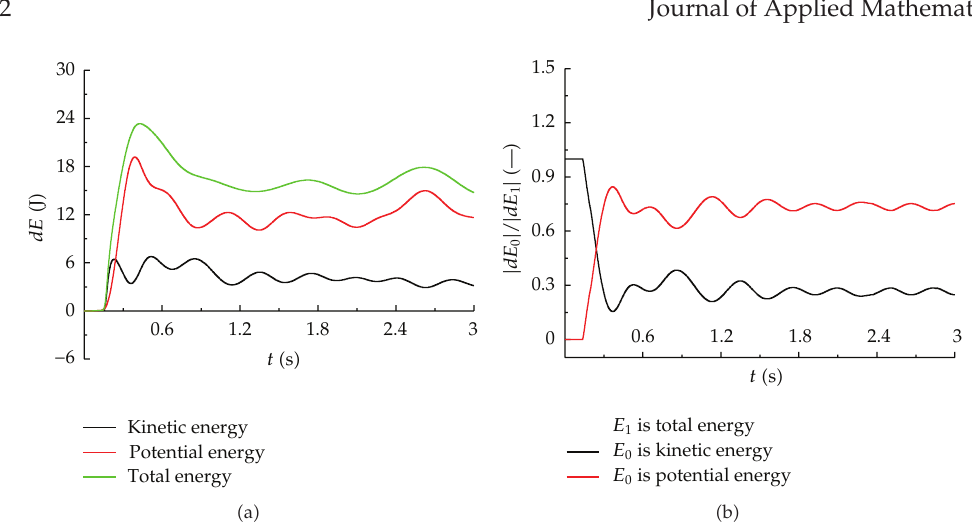
Figure 7: Time histories of accumulative variation of energy (cid:2) a (cid:3) and its ratio (cid:2) b (cid:3) in fluid field.